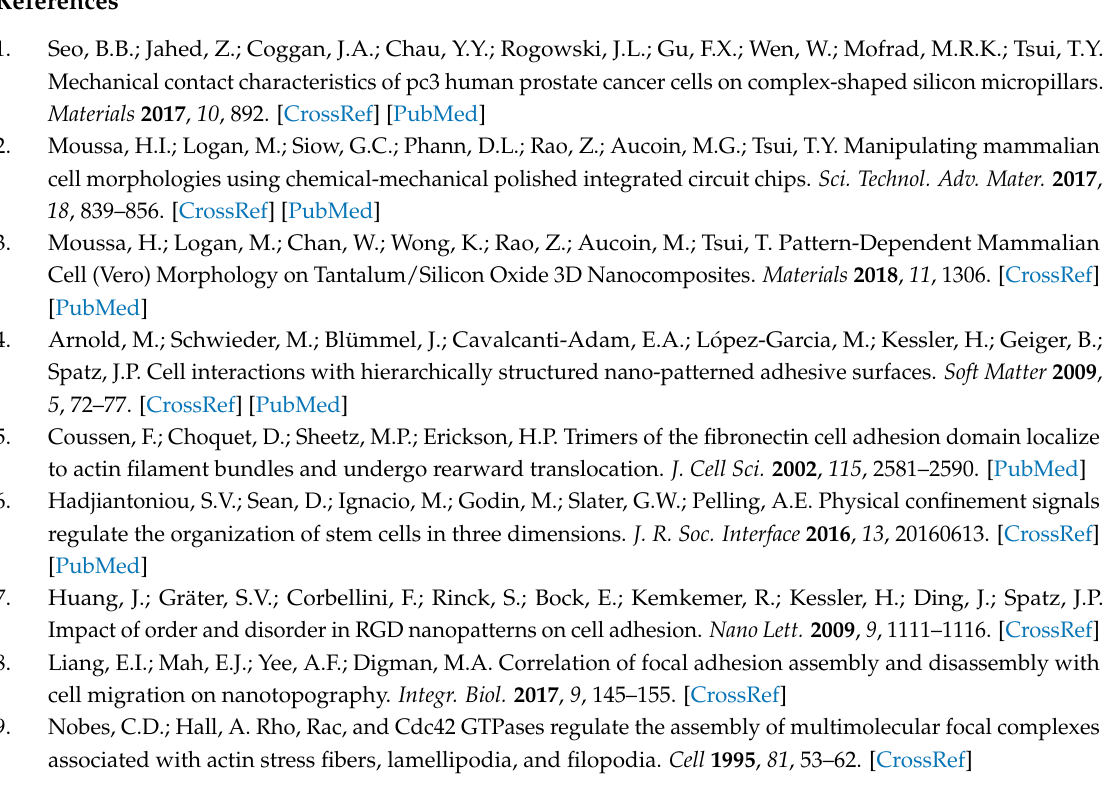
0.5 µ m comb structures, Figure S2c: Low- and high-magnification fluorescence confocal micrographs of cells on 0.18 µ m comb structures, Figure S2d: Low- and high-magnification fluorescence confocal micrographs of cells on 0.18 µ m comb structures, Figure S3a: Low- and high-magnification SEM micrographs of comb structures with line and trench widths of 0.18 µ m, Figure S3b: Low- and high-magnification SEM micrographs of comb structures with line and trench widths of 0.18 µ mm, Figure S3c: Low- and high-magnification SEM micrographs of comb structures with line and trench widths of 0.25 µ m, Figure S3d: Low- and high-magnification SEM micrographs of comb structures with line and trench widths of 0.25 µ m, Figure S3e: Low- and high-magnification SEM micrographs of comb structures with line and trench widths of 50 µ m, Figure S4: Pseudopodia morphology of cells on the 0.18 µ m comb structure. High-magnification images show the nanometer scale pseudopodia filaments bridged across the trench structures. More importantly, micrographs show the cleaving process did not produce observable damages to the patterned line structures and the cells. Nanometer scale filaments can be seen bridging the trenches adjacent to the fractured surfaces, Figure S5: Tilted SEM micrographs of three cross-sectioned cells (a–c). All cells are adhered to the 0.18 µ m patterned structure. Landmarks “1”–“6” are visual aids to match the surface features, Figure S6: Tilted SEM micrographs of two cross-sectioned cells (a) and (b). (a) Cell is adhered on two surface structures–flat surface and 0.18 µ m patterned structure. (b) Entire cell is on the 0.18 µ m comb structure. Both fractured surfaces are displayed (left and right columns of images). Landmarks “1”–“6” are used to aid viewers to match the surface features. Dash lines in (a) mark the boundaries between the two patterned surfaces, Figure S7: Tilted SEM micrographs of two cross-sectioned cells (a) and (b) on the 0.5 µ m patterned structure. Landmarks “1”–“4” are used to aid matching the surface features, Figure S8: Tilted SEM micrographs of a cross-sectional cell adhered on the 2 µ m trench patterned structure. Landmarks “1”–“3” are used to aid matching the surface features. Note the center portion of this nucleus bridges across the trench while the rest of the cell conformal coat the surface